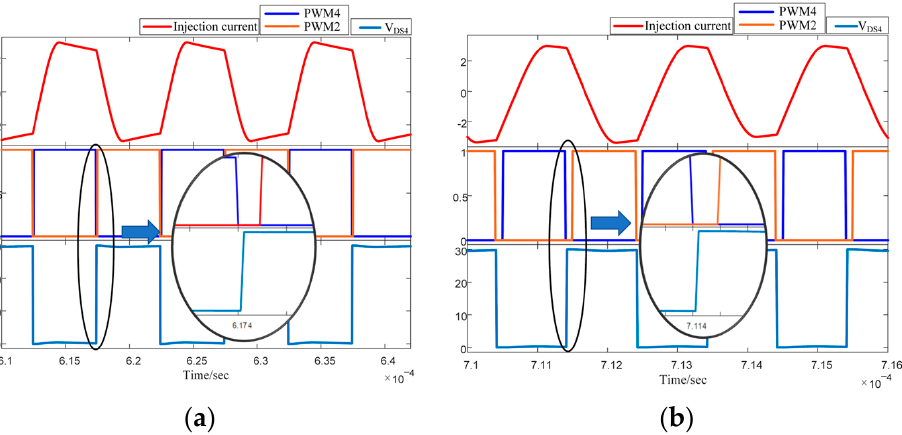
Figure 10. The main waveforms of the injected current and lagging bridge arm at 100 kHz and 500 kHz. ( a ) The main waveforms of the lagging bridge arm and the injected current at 100 kHz; ( b ) The main waveforms of the lagging bridge arm and the injected current at 500 kHz.